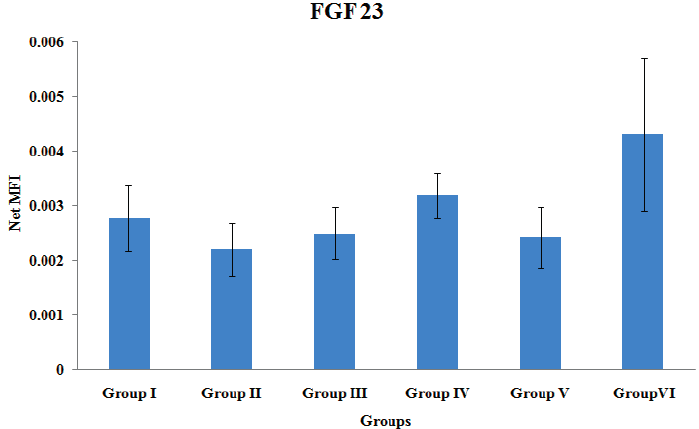
Figure 9. FGF 23 Gene Expression. Samples were normalized to GAPDH MFI (Median Fluorescence Intensity). Values were expressed as mean ± SEM. Group I: sham-operated group, Group II: ovariectomized control group, Group III: ovariectomized+Estrogen, Group IV: ovariectomized+Lovastatin, Group V: ovariectomized+Tocotrienol, Group VI: